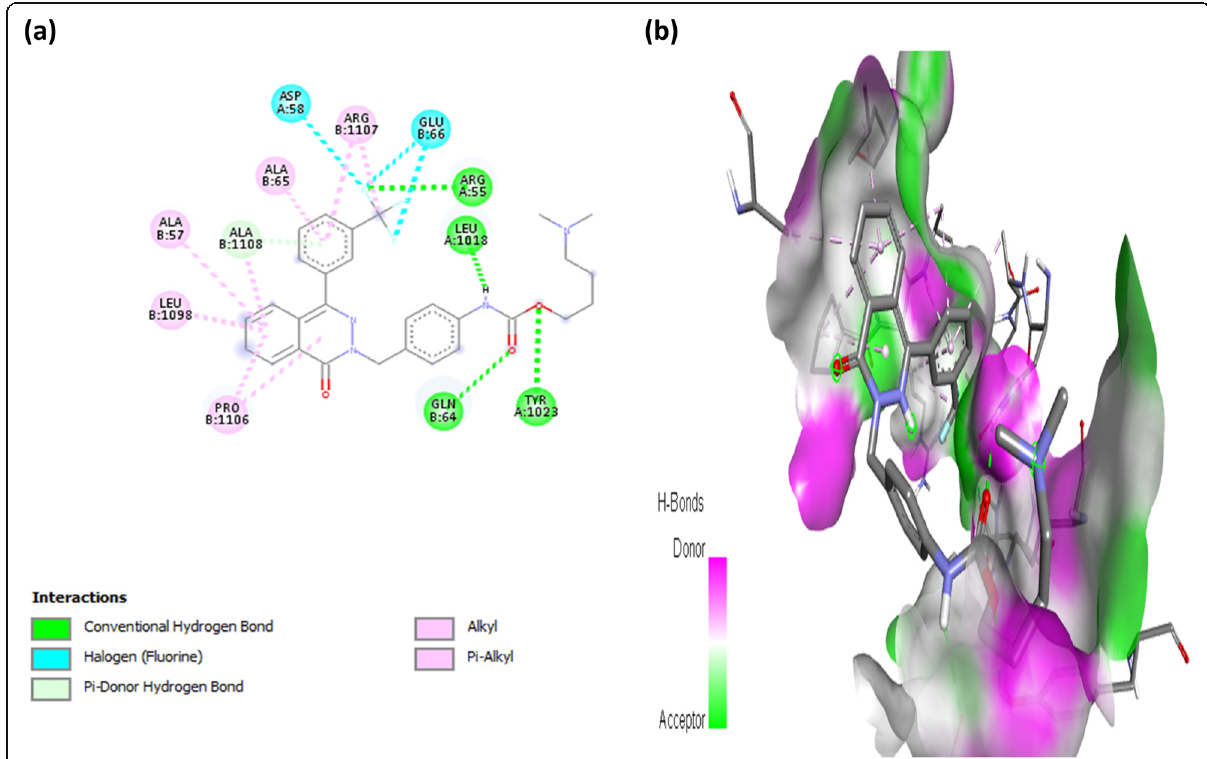
Fig. 7 2-D interaction type ( a ) and H-bond molecular interaction ( b ) between Ligand 21 and the